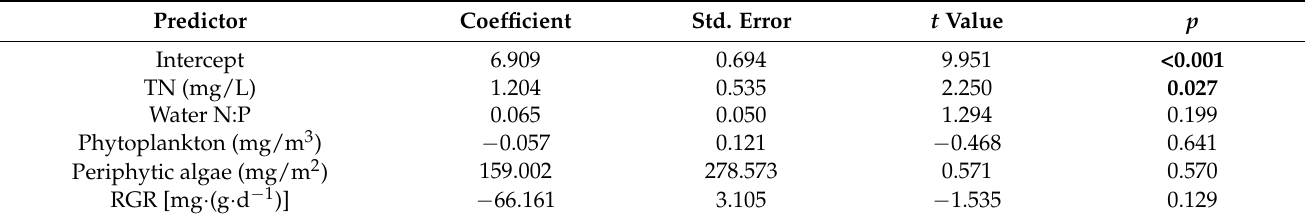
Table 8. Summary of the best model of the relationship between V. natans N:P and water N:P. Predictor